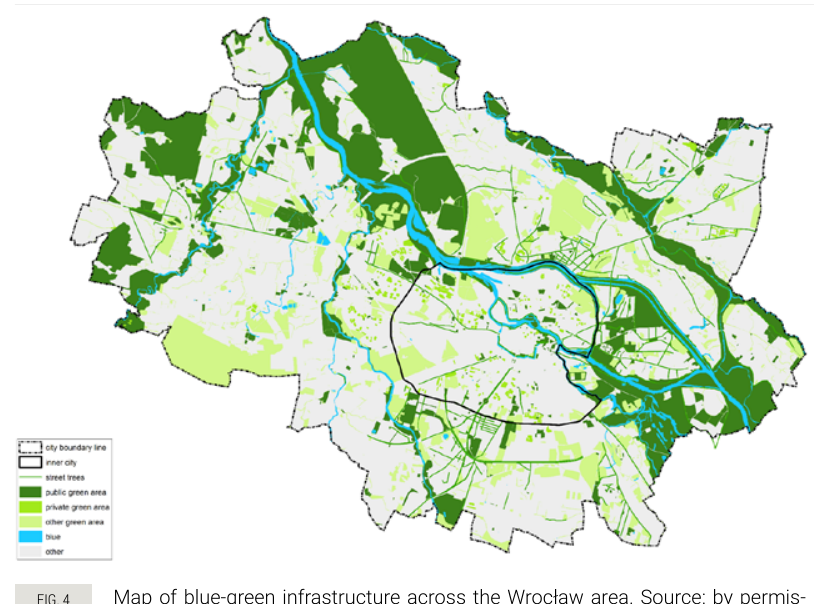
Map of blue-green infrastructure across the Wrocław area. Source: by permis- FIG. sion of Municipality of Wrocław.